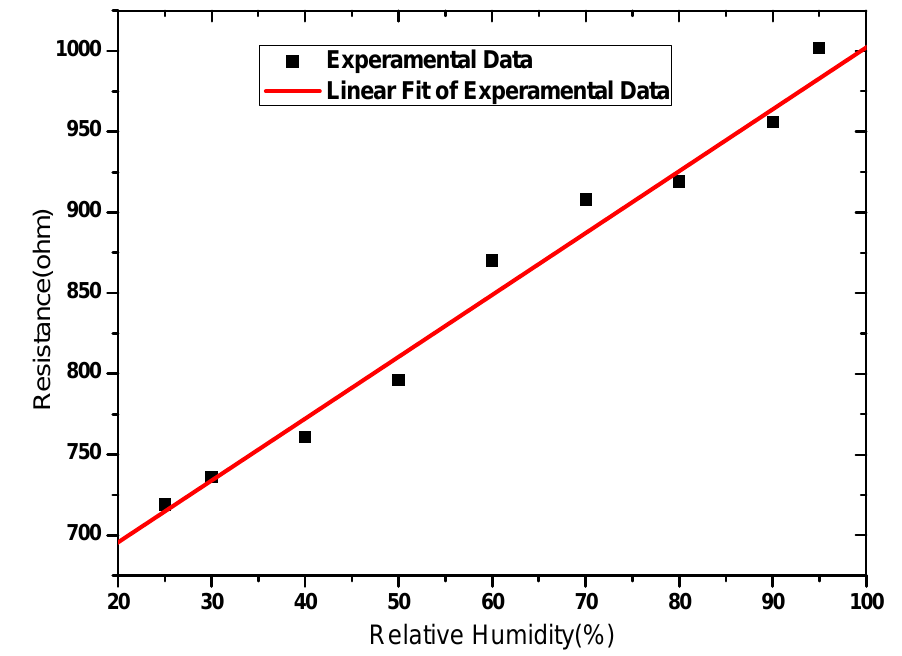
Figure 4. Resistance-relative humidity data and linear fit of a MWCNT network obtained at room